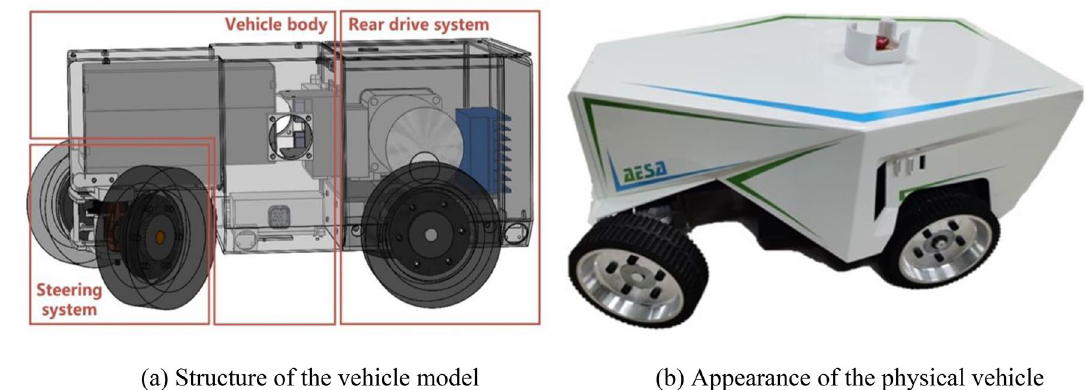
Figure 2 Model and photo of the developed Intelligent connected electric